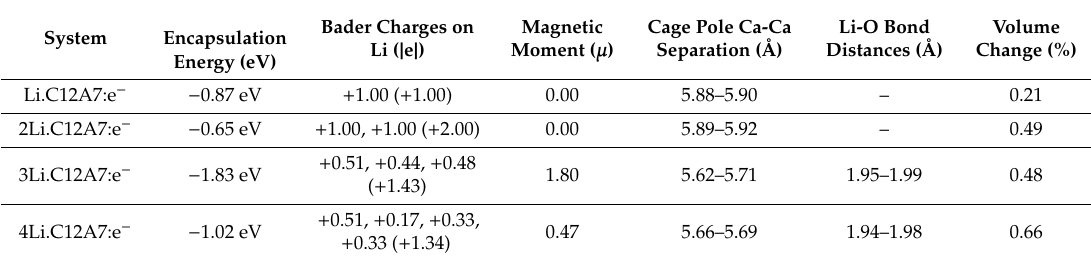
− Figure 5j–n. In C12A7:e , four electrons are uniformly distributed. Upon encapsulation, the electron density in the lattice increases due to the additional electrons coming from the Li